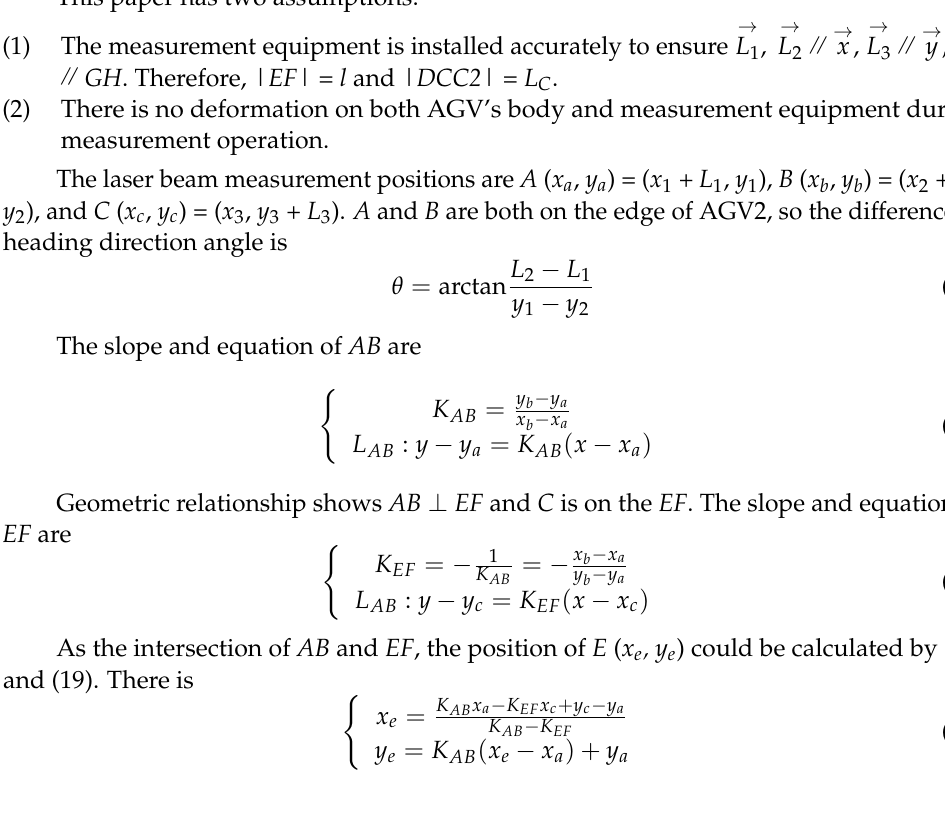
Figure 11. Measurement system schematic diagram.